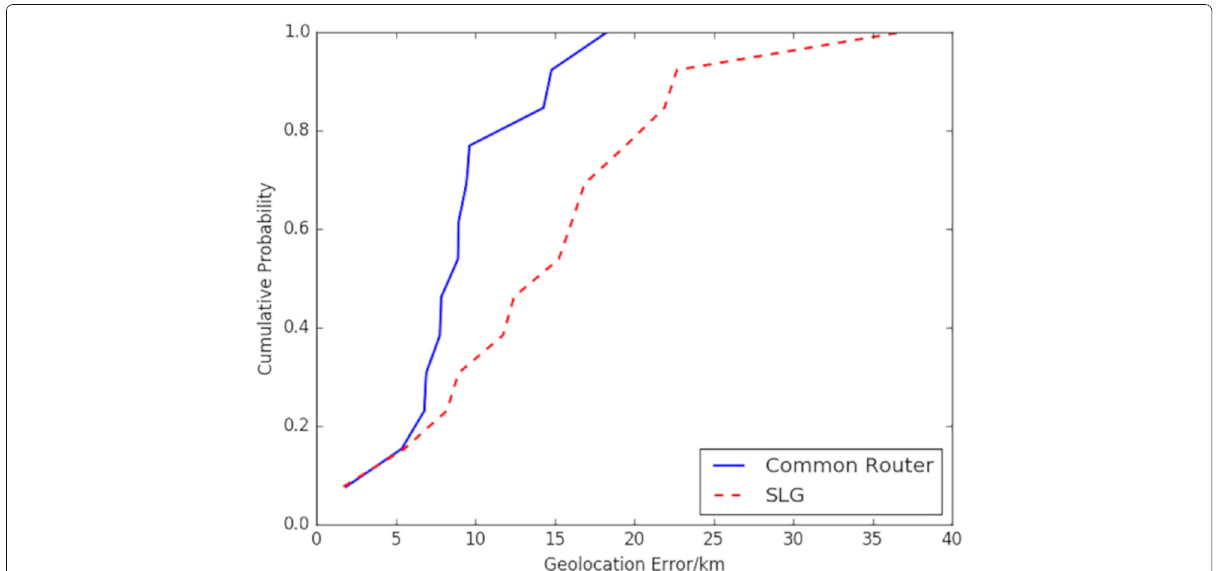
Fig. 8 Cumulative distribution of geolocation error of CRG and SLG